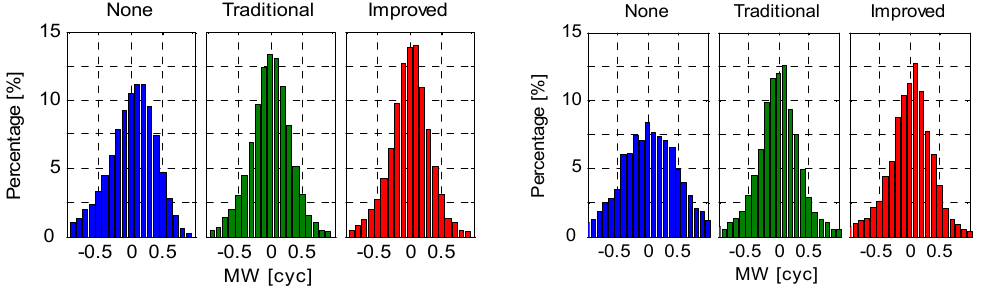
Figure 14. Histograms of all the derived MW values ( left : IGSOs; right : MEOs) on XMIS (DoY 130/2015).